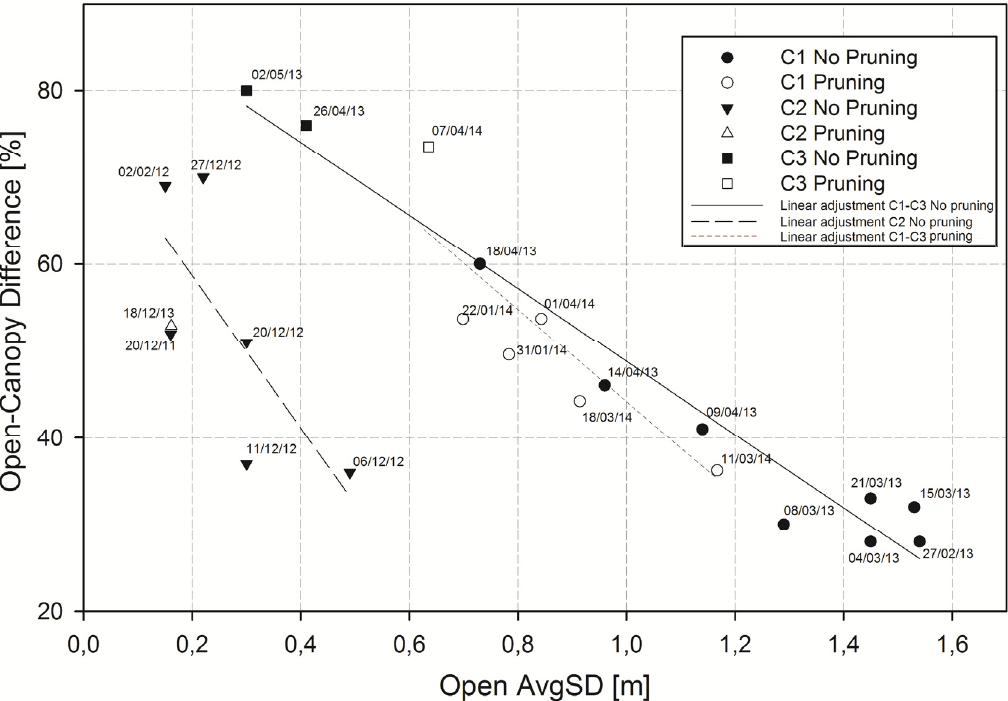
Figure 5. Open-Canopy differences plotted as a function of the average snow depth for the survey dates associated with each PCA component. The continuous black line shows the linear trend obtained for the C1–C3 survey dates (prior to pruning), the dashed black line shows the linear trend for the C2 survey dates prior to pruning and the dotted line shows the linear trend of C1/C3 surveys after pruning.